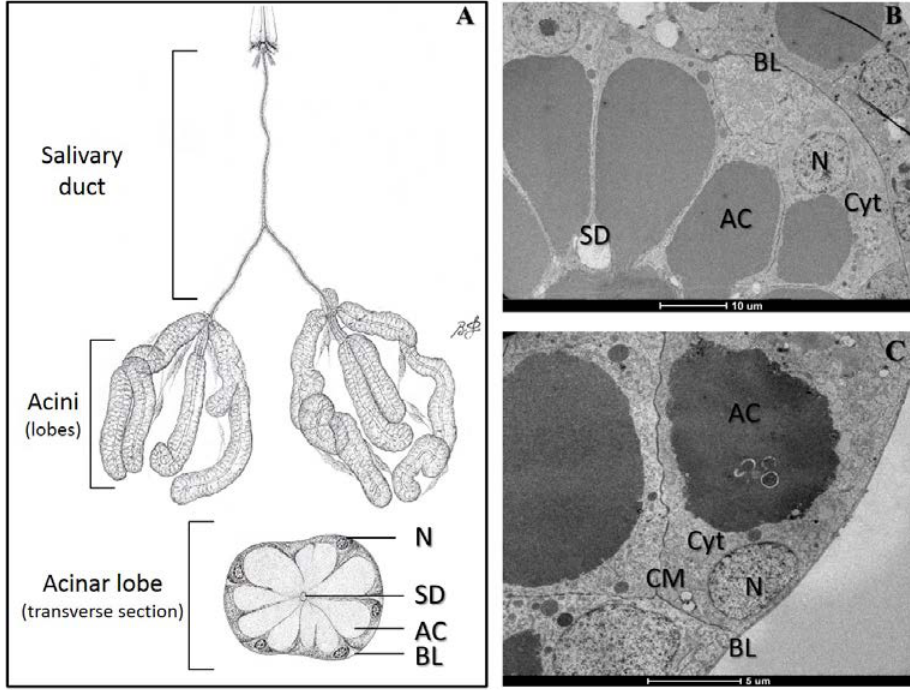
Figure 1. Structure of Ae. albopictus salivary glands. ( A ) Schematic representation of salivary glands in Aedinae mosquitoes (Modified from Jobling, 1987); ( B , C ) Ultrastructural views of transverse-sections of an acinar lobe or acinus. N: nuclei. SD: salivary duct. AC: apical cavity for saliva storage. BL: basal lamina. Cyt: Cytoplasm. CM: Cell membrane. Images were captured using a FEI Tecnai Biotwin transmission electron microscope (Eindhoven, The Netherlands).